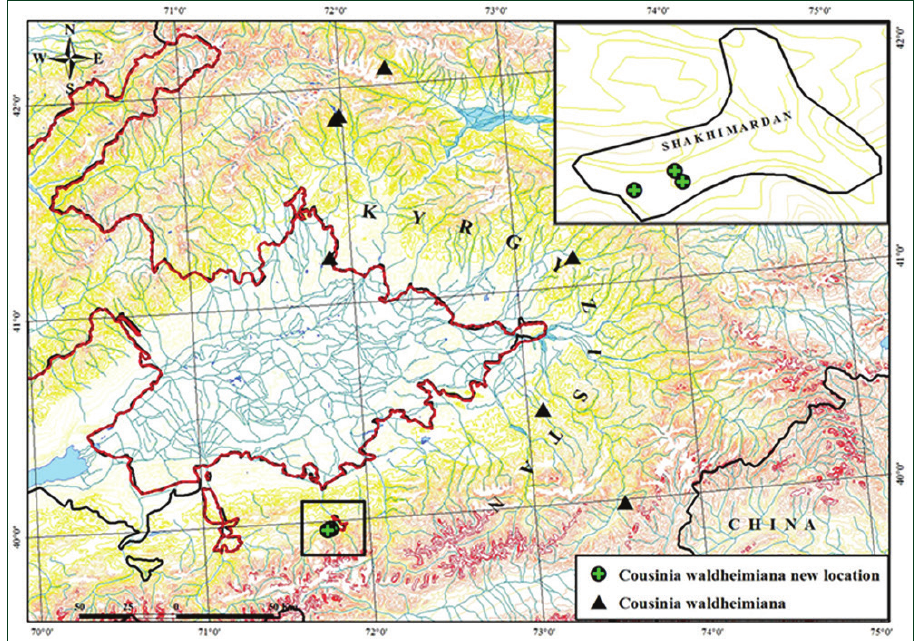
Figure 2. Distribution map of C. waldheimiana in Uzbekistan and the neighboring territories (according to the specimens